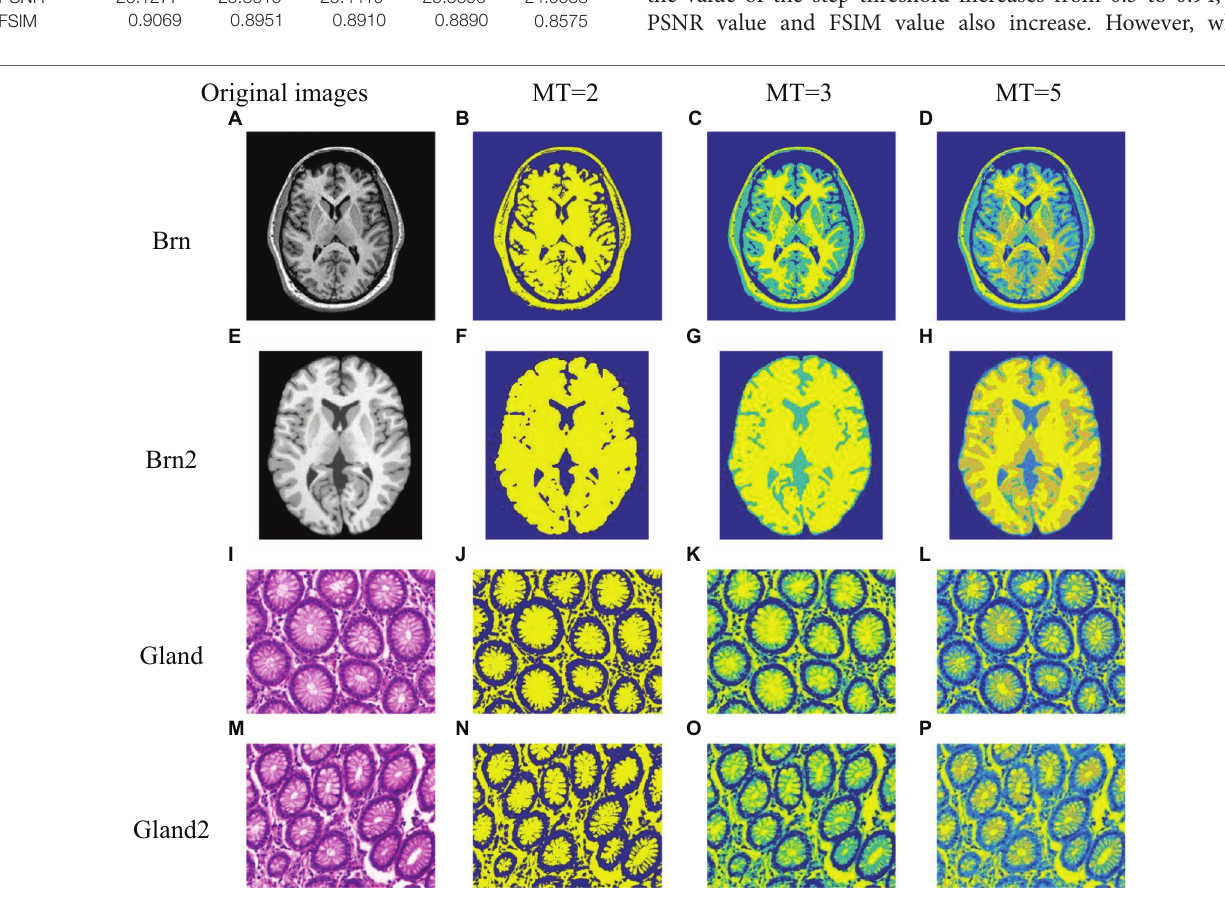
FIGURE 1 | The medical image segmentation results based on the ISBO. (A-P) only characterize the serial numbers of different experimental images.